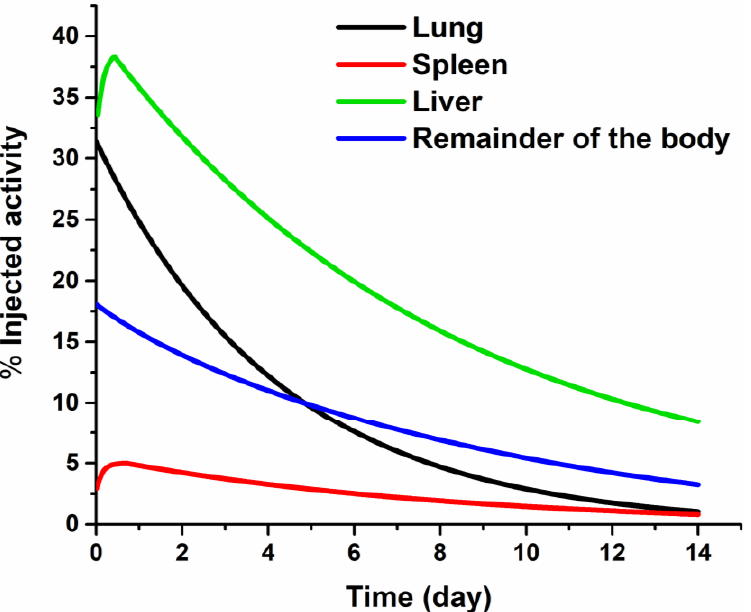
Figure 6. Biokinetic behavior of the source organs after the intravenous administration of 177 Lu 2 O 3 - iPSMA nanoparticles in a patient with multiple colorectal liver metastases.